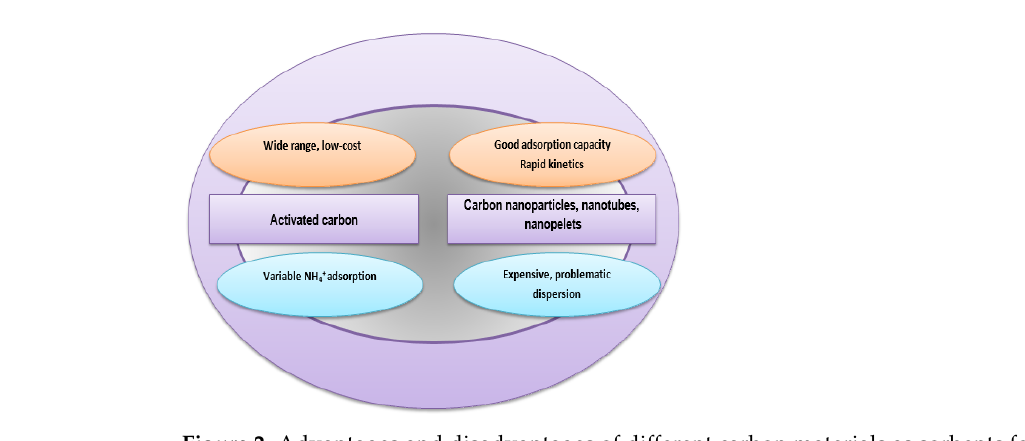
Figure 2. Advantages and disadvantages of different carbon materials as sorbents for ammonium removal from water. Table 1. Admitted approaches for ammonium removal from natural